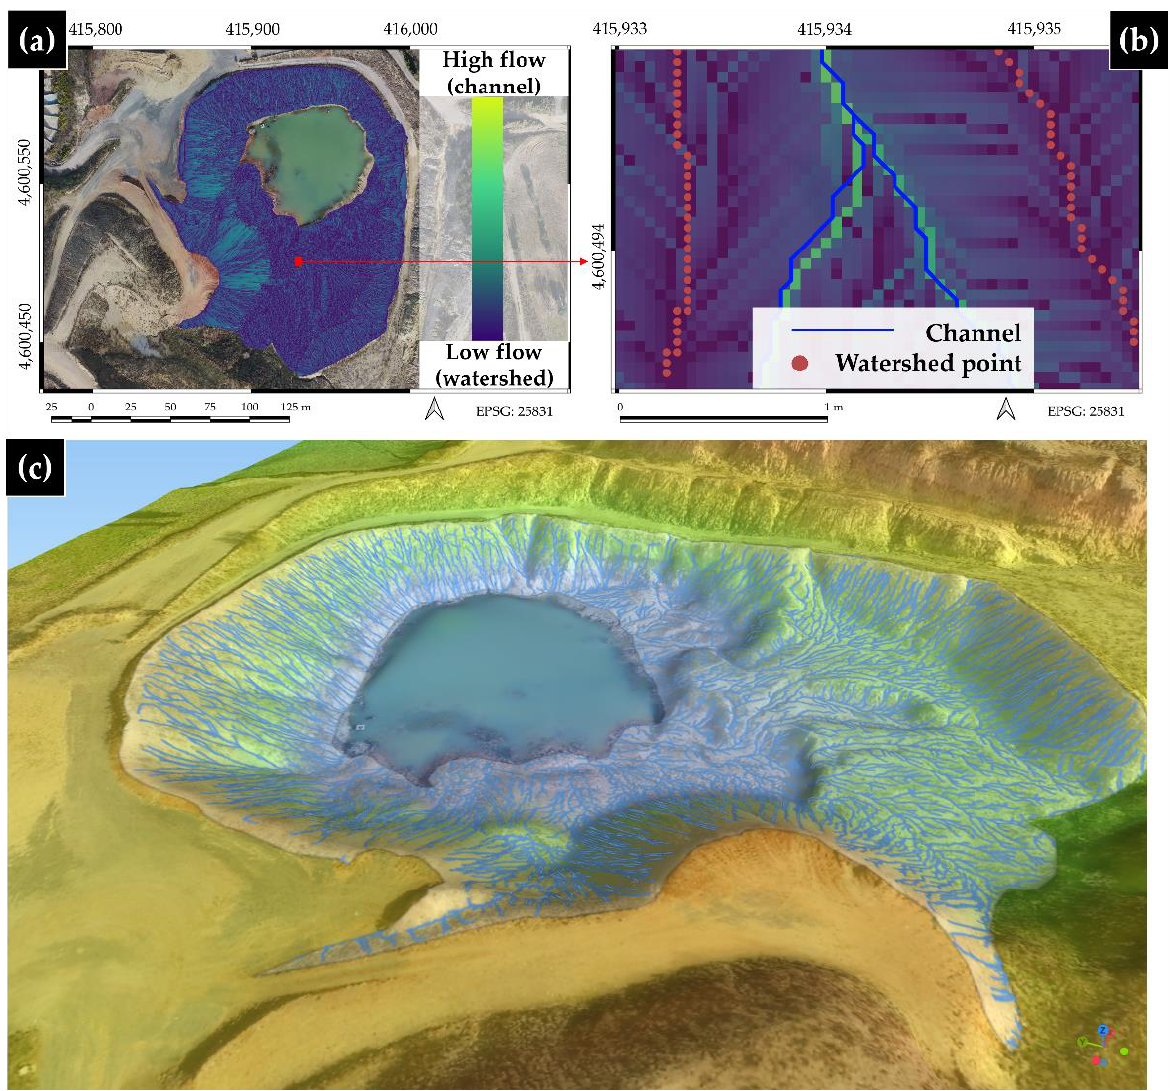
Figure 5. ( a ) Flow water catchment (Log10 for better visualization) of the Area of Interest (AOI) based on DEM T1 . ( b ) Zoom of ( a ), with the channels and the XYZ points located over the watershed, which were used to build DEM T0 . ( c ) 3D representation of DEM T1 with the channel network. Once detected, the channels, together with the DEM T1 , were used to delimit the watershed network. The selection of the XYZ points of the dense point cloud, located over the watershed lines, was the key to obtaining the reference altitudes on the ridges, being the T0 estimation. Interpolating the Z coordinate at the ridges, it was possible to